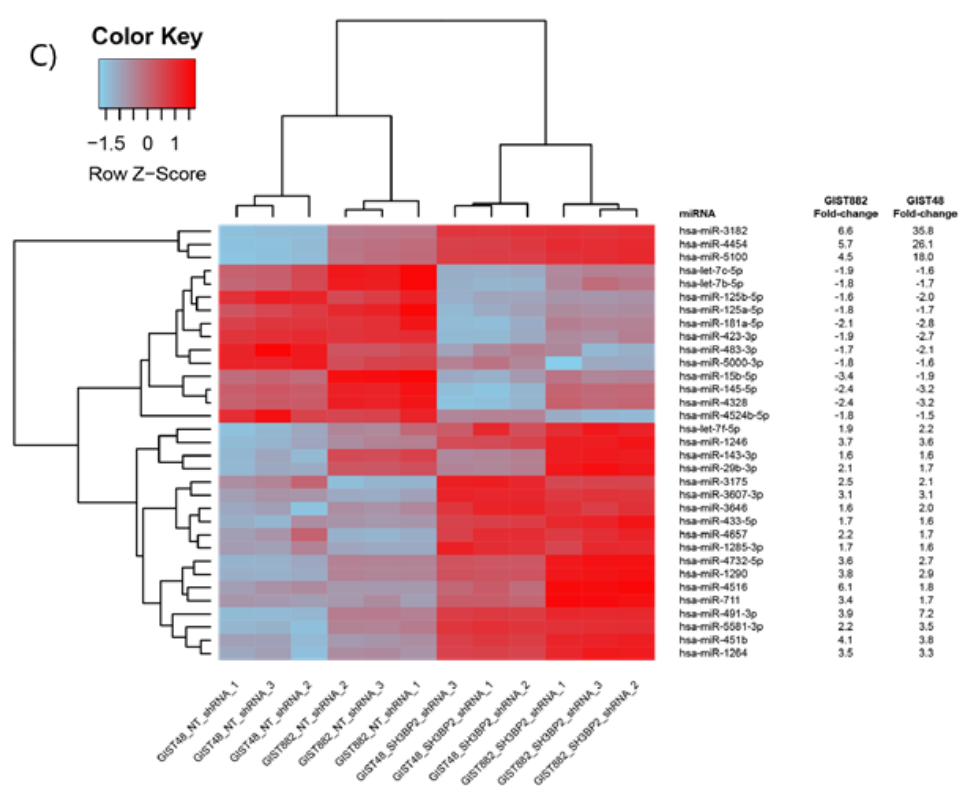
Figure 2. Profile of miRNA expression in SH3BP2-silenced GIST cells. Heat map representation of two-way hierarchical clustering of the miRNAs altered in GIST48 and GIST882 after 3BP2 silencing. ( A ) Venn diagram of miRNAs altered after SH3BP2 silencing. The expression of 107 miRNAs was significantly altered in both cell lines ( p -value < 0.05). ( B ) A four-way Venn diagram shows the overlapping of the different miRNAs in both cell lines. The clustering was done using the complete- linkage method and Euclidean distance measure. ( C ) Each column represents a single sample, and each file represents a single miRNA. The red and blue colors represent high and low relative expressions, respectively ( p -value < 0.05).